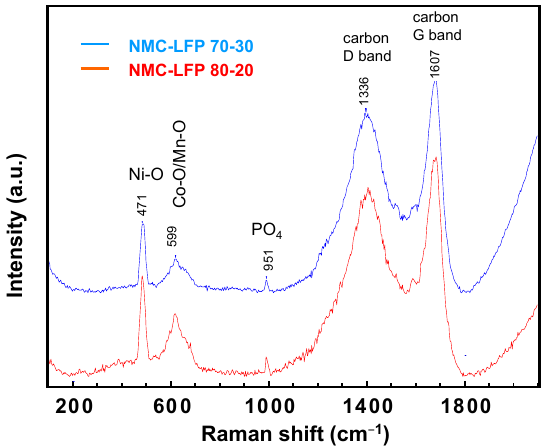
Figure 7. Raman spectra of NMC–LFP blends. Spectra were recorded using a 514.5 nm laser line excitation.